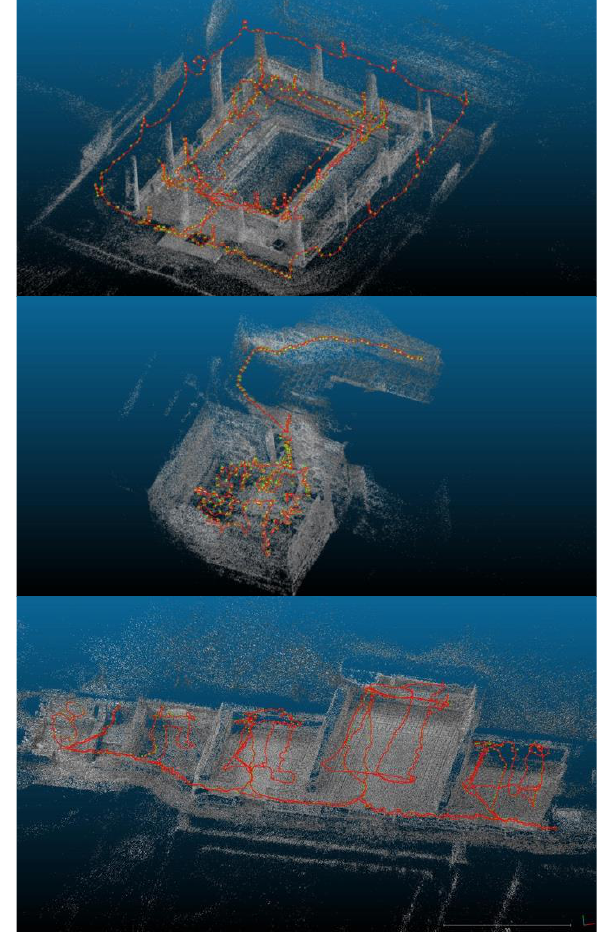
Figure 3. Trajectories followed to document the three study areas. Area 1(up), area 2 (middle), area 3 (bottom). The red line defines the trajectory followed and the green dots, the positions of the Keyframes calculated.